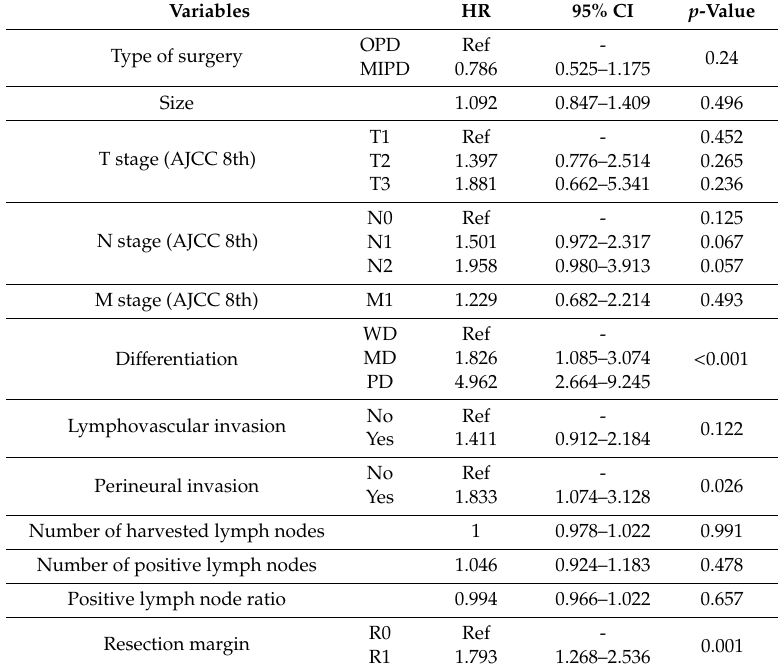
Table 7. Multivariable model of risk factors for overall survival after propensity score